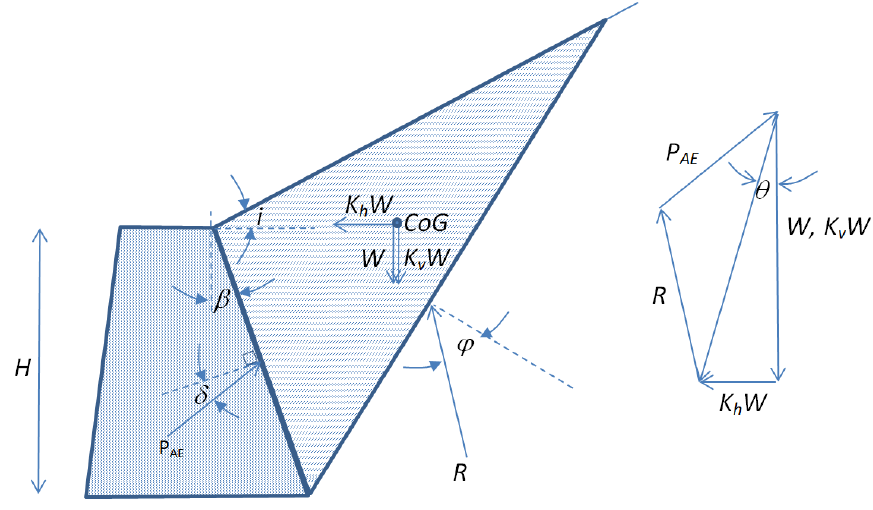
Figure 1. Stability checks for reinforced concrete retaining walls.